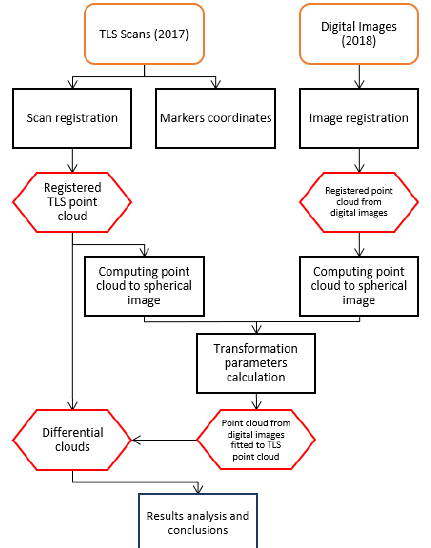
Figure 1 : The schematic of the performed